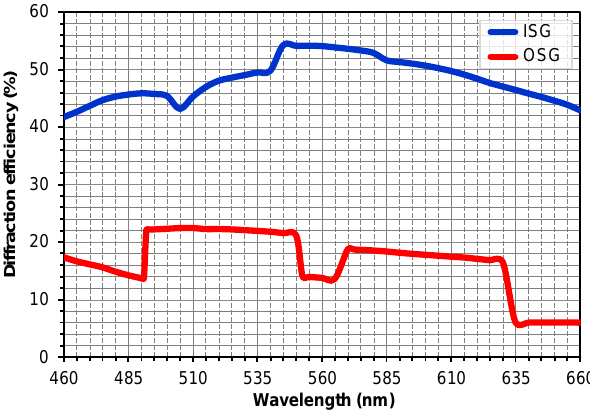
Figure 8. Di ff raction e ffi ciencies (DEs) of all possible di ff raction orders combined of the ISG and OSG calculated with respect to the wavelength. The average DEs of the ISG and OSG over the entire spectrum (460 to 660 nm) are 48.0% and 16.7%, respectively.